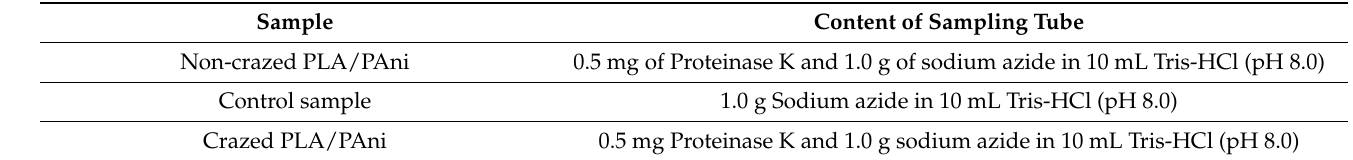
Table 1. Content of each sample tube during the biodegradation